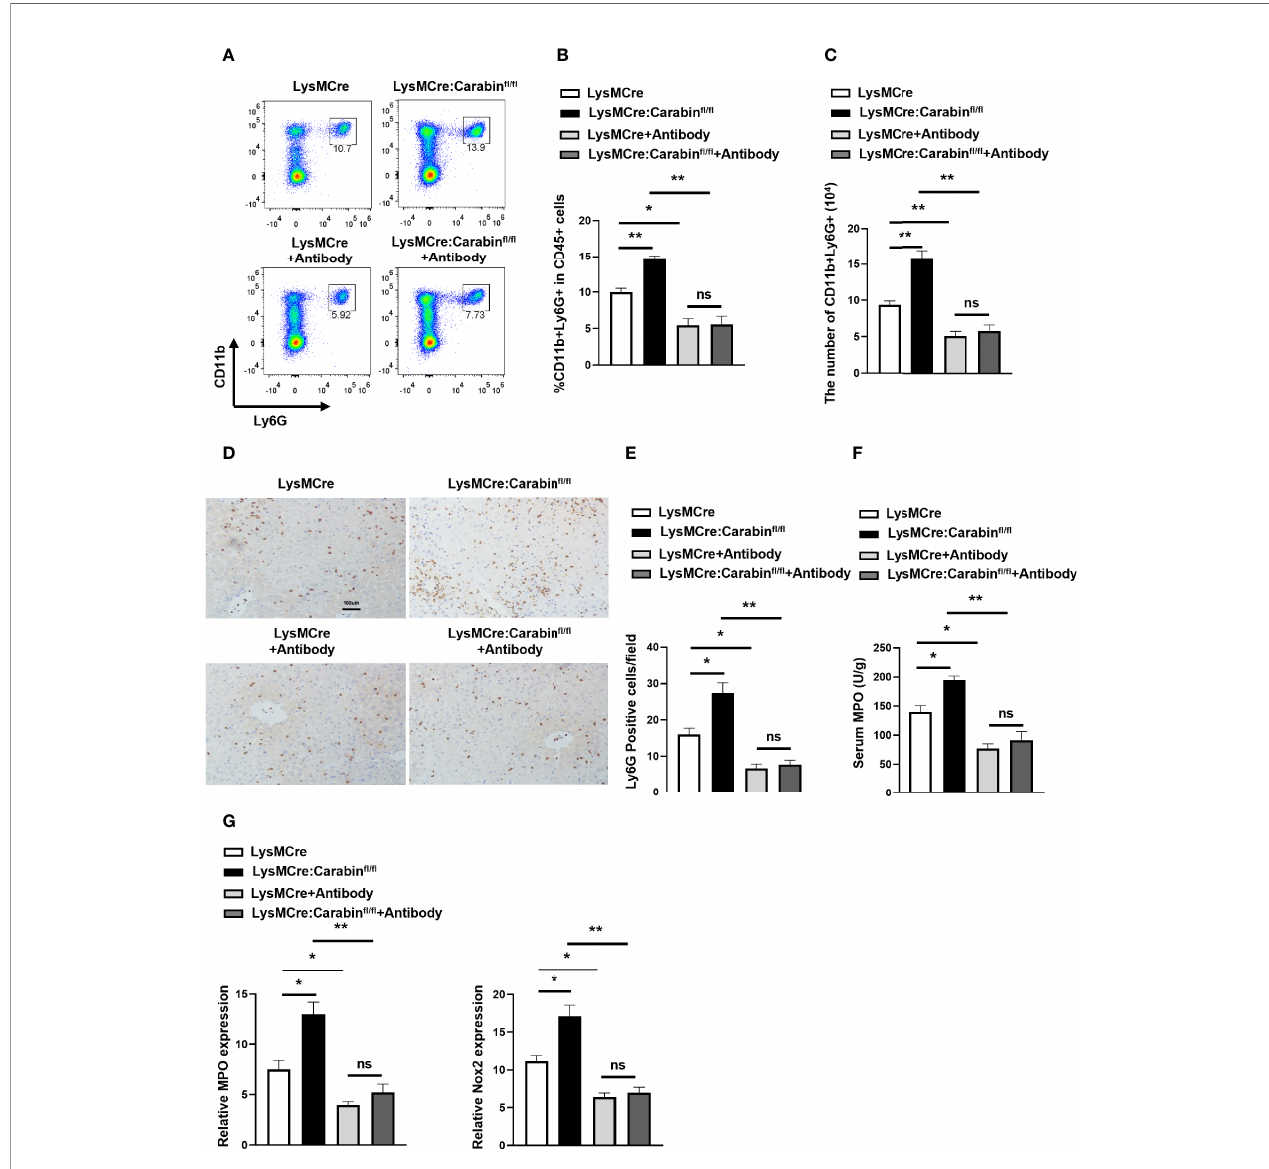
FIGURE 5 | Carabin alleviates hepatic I/R injury through inhibiting the expression of P-selectin, E-selectin, and a v b 3 integrin. (A) Flow cytometry measuring granulocytes (CD11b + Ly6G + ) in liver-in fi ltrating leukocytes. (B) Statistical analysis of the percentage of CD11b + Ly6G + cells in liver-in fi ltrating leukocytes. Data are presented as mean ± SEM (n = 5 mice/group). (C) Statistical analyses of the number of CD11b + Ly6G + cells in liver-in fi ltrating leukocytes. Data are presented as mean ± SEM (n= 5 mice/group). (D) Ly6G-positive cells in liver tissues were detected by immunohistochemistry. Scale bar, 100 µm. (E) Statistical analyses of the number of Ly6G-positive cells. Data are presented as mean ± SEM (n= 5 mice/group, 3-5 fi elds were quanti fi ed). (F) Serum MPO levels were measured by ELISAs. Data are presented as mean ± SEM (n = 5 mice/group). (G) The mRNA levels of MPO and Nox2 were measured by qRT-PCR. Data are presented as mean ± SEM (n = 5 mice/group). *P < 0.05; **P < 0.01; ns, not signi fi